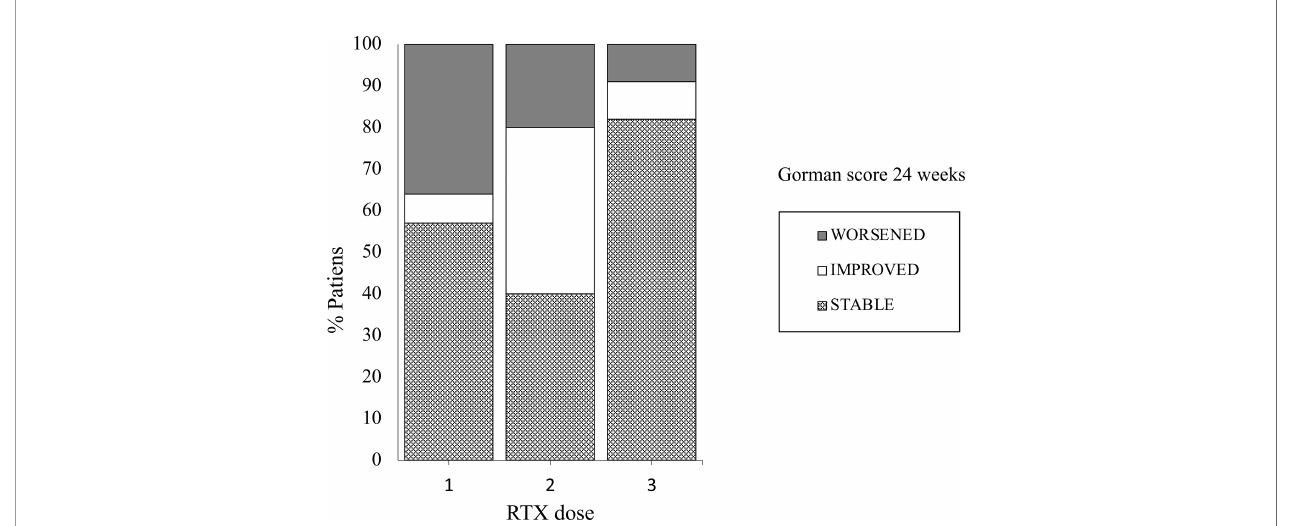
FIGURE 2 | Proportions of patients with GO with modi fi cations of the Gorman score for diplopia after treatment with three different doses of RTX: 1= Group 1 (RTX 100 mg); 2= Group 2 (RTX 500 mg); 3 Group 3 (RTX 1000 mg x 2). Chi Square